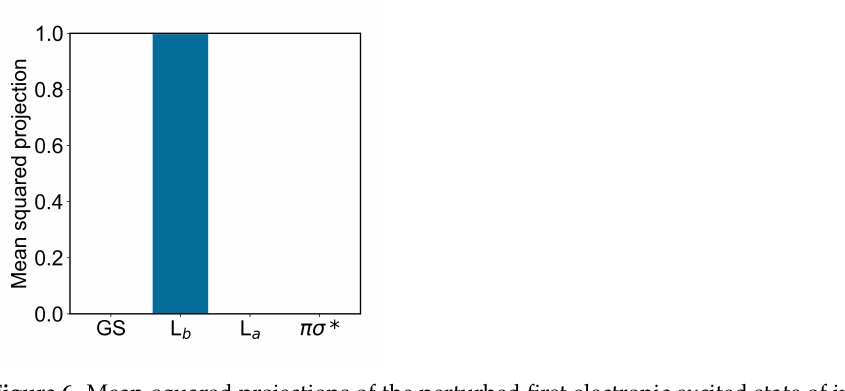
Figure 6. Mean-squared projections of the perturbed first electronic excited state of indole, on the first four unperturbed electronic eigenstates (the ground state GS, the excited states L b , L a and the dark state πσ ∗ , in the figure ordered according to increasing energy) as obtained at the L b geometry by the L b -state MD ensemble.